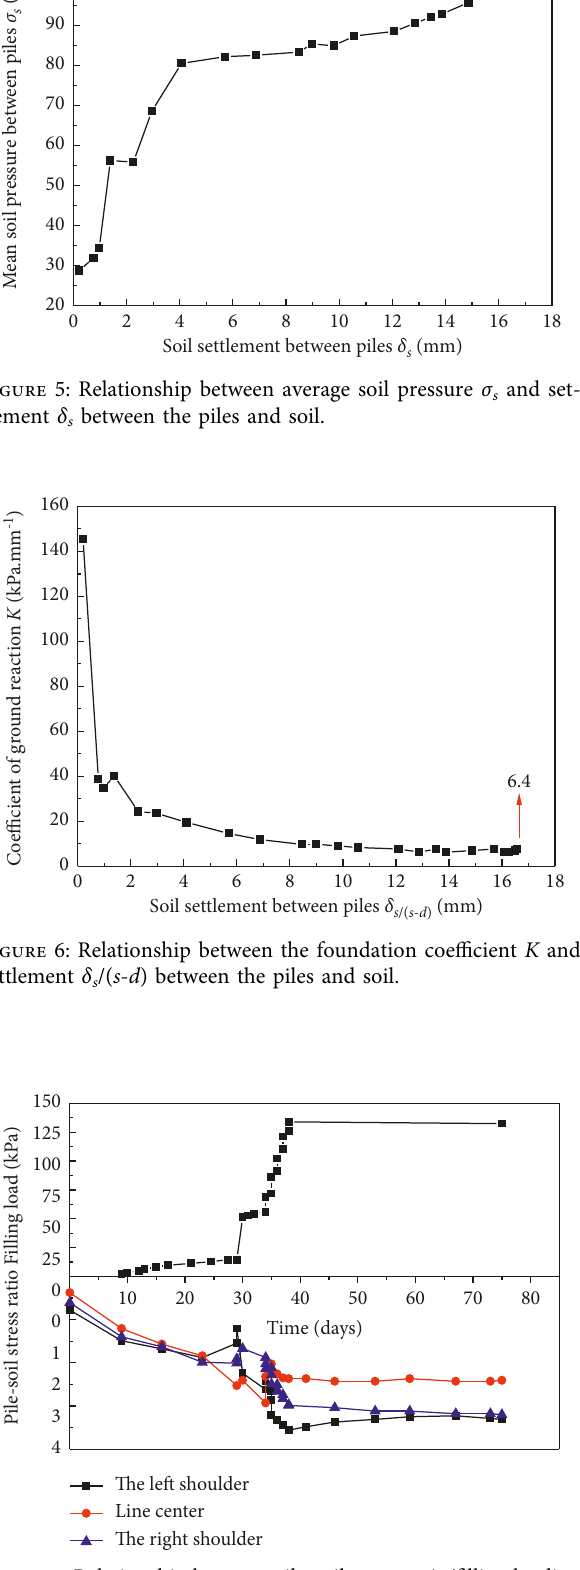
Figure 7: Relationship between pile-soil stress ratio/filling loading and the